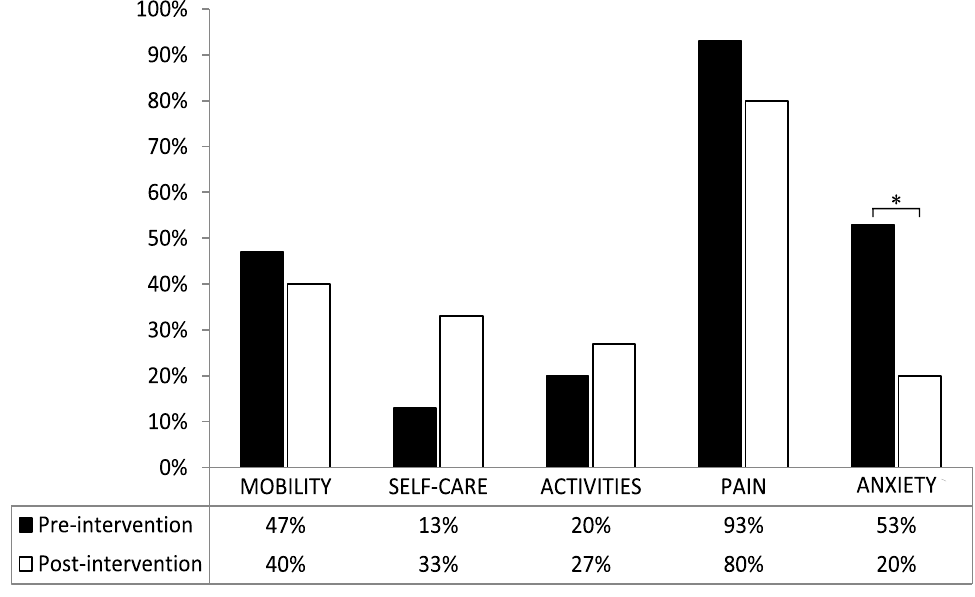
Figure 2. Percentage changes in pre and post-intervention of EQ-5D variables. * p < .05